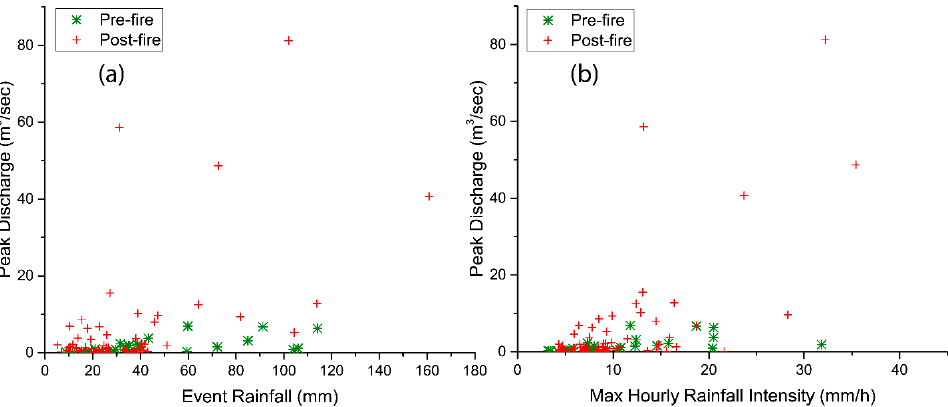
Figure 3. Peak hourly discharges for the events that took place in the pre-fire and the post-fire period in comparison with the ( a ) total rainfall depth and ( b ) the maximum hourly rainfall intensity for each event.